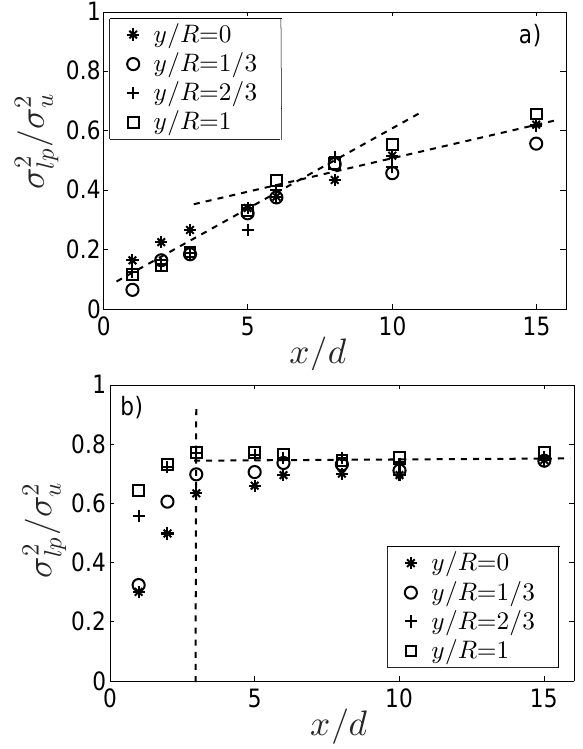
Figure 9. Relative energy of large scale fluctuations in the ( a ) LT ; and ( b ) HT